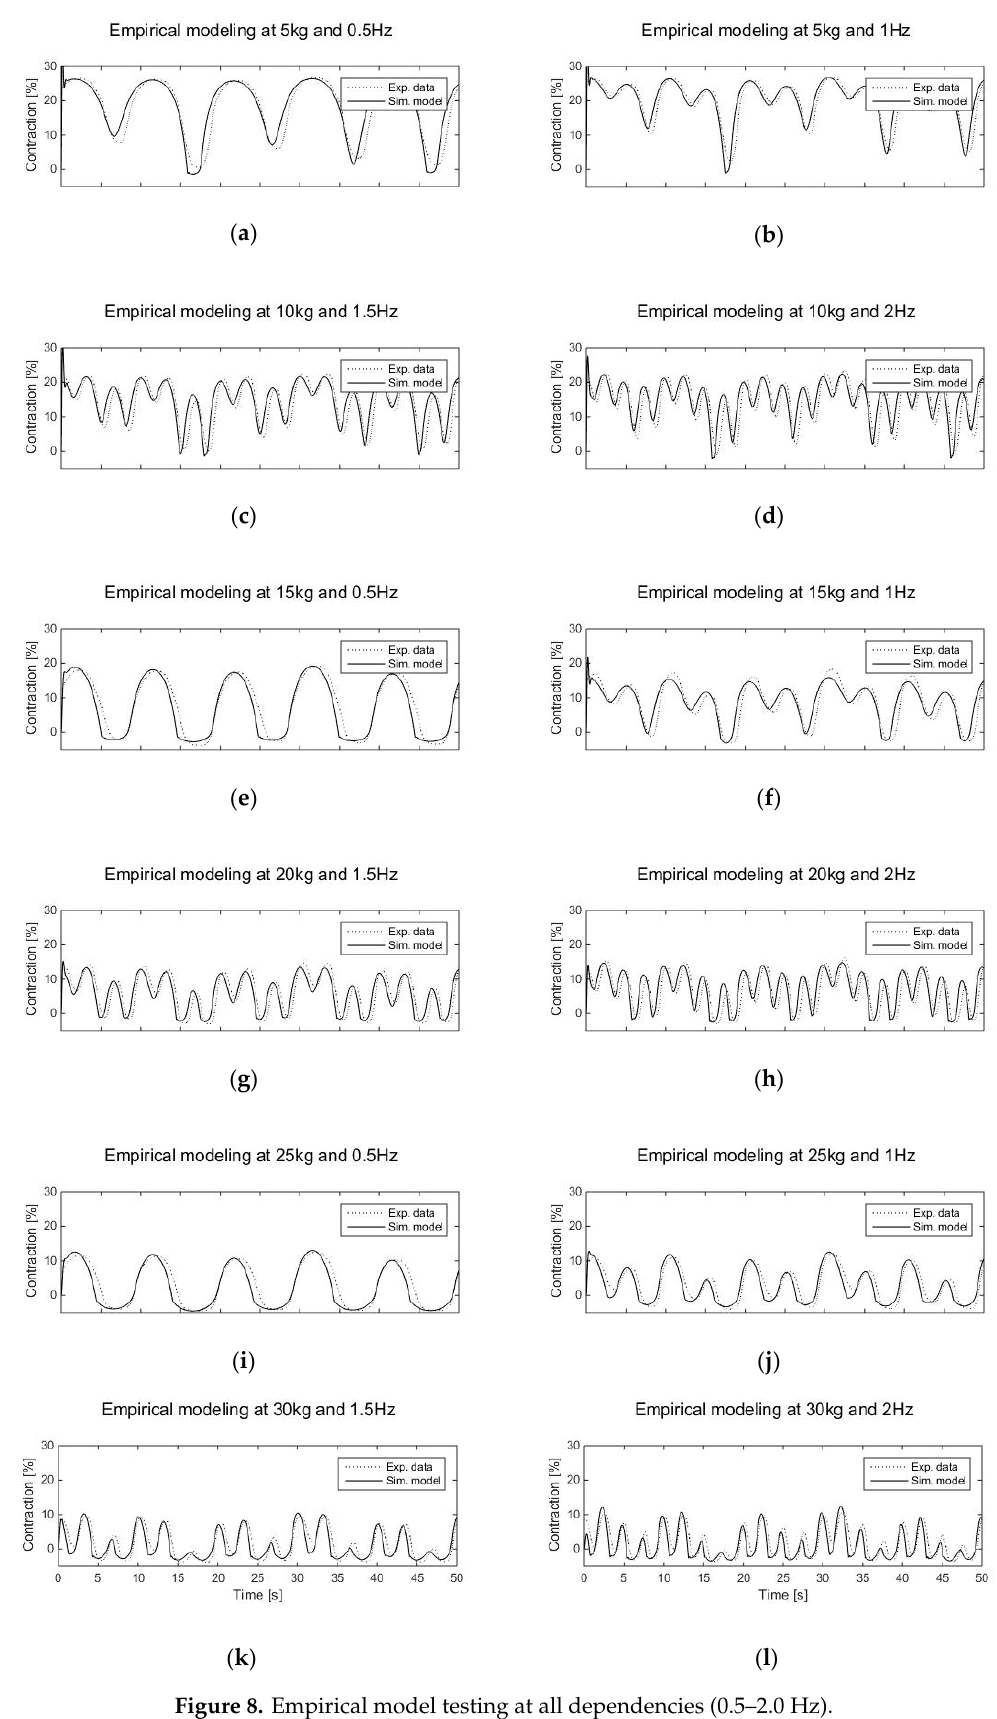
Figure 8. Empirical model testing at all dependencies (0.5–2.0 Hz).